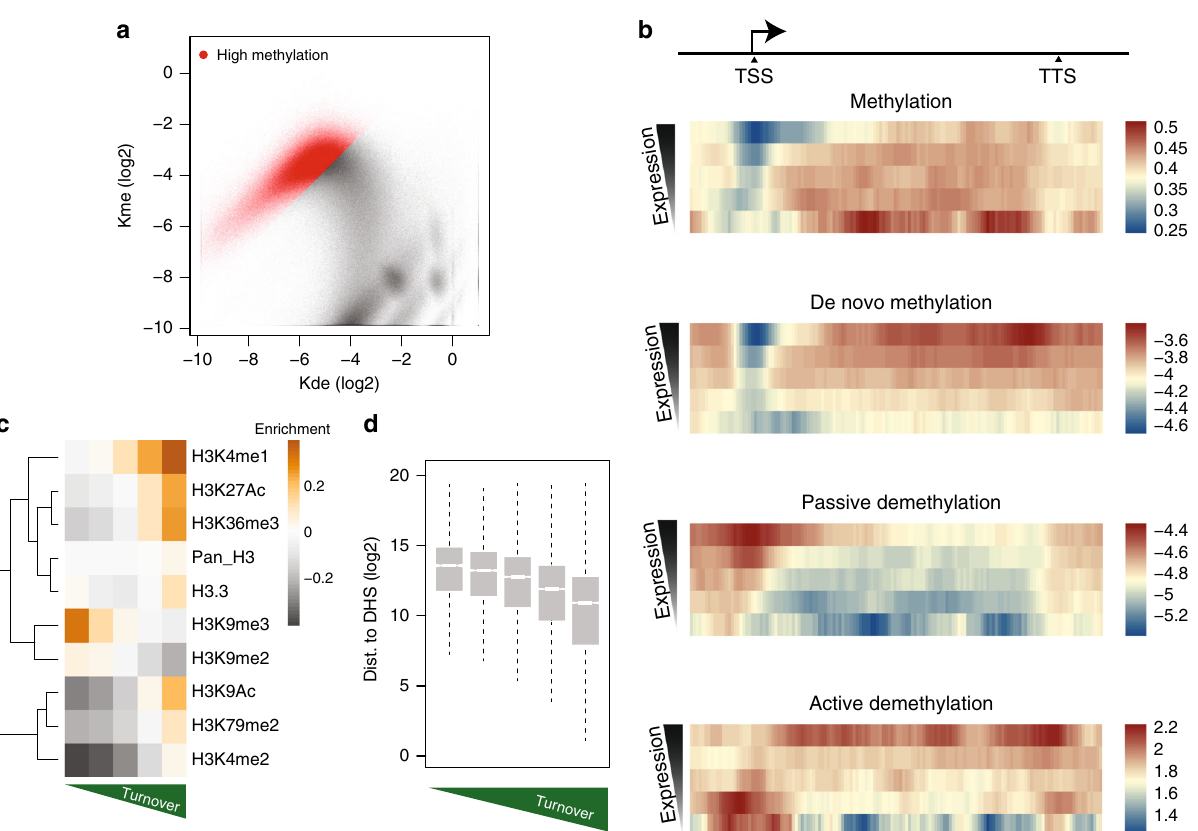
Fig. 5 Turnover at highly methylated cytosines correlates with genomic activity. a Scatterplot of k de and k me highlighting CpGs in red that have a high steady state ≥ 70%). b Rates and methylation levels as a function of location in genic regions. Mean values for CpGs are represented as a function of their position in genes as a percentage (i.e., each genic region represents 100 bins). Upstream and downstream of noted TSS and TTS regions represent 10 kb of fl anking DNA. Each row in the heatmap represents a collection of genes binned on transcriptional output in RPKM ( fi ve bins total), with the highest expressing bin on top. Each bin represents at least 2k genes. c Heatmap representing signal for eight different chromatin marks across bins of highly methylated cytosines (red points from a ). Mean histone signal was calculated by tiling the genome into 1 kb bins and determining enrichment in ChIP signal over input for the respective marks. From left to right, bins are split based on mean methylation turnover within the bin, with the highest turnover bin on the far right. Note the increase in H3K36me3 and active marks, with the concomitant decrease in H3K9me2/3. d Turnover increases with proximity to distal regulatory elements. CpGs were binned on turnover as for c , but their distance to the nearest DHS site was calculated. Boxplot elements are as de fi ned in Fig.